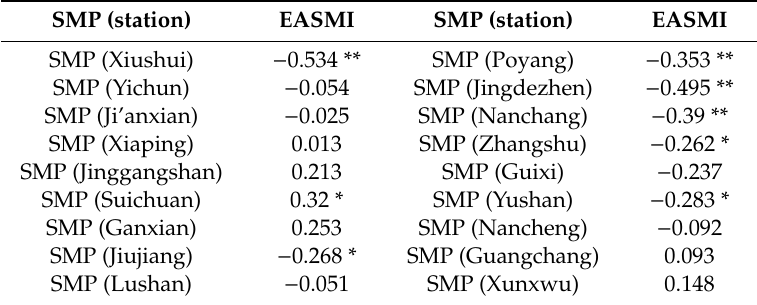
Table 2. Correlation coe ffi cients between the East Asian Summer Monsoon Index (EASMI) and summer precipitation (SMP).